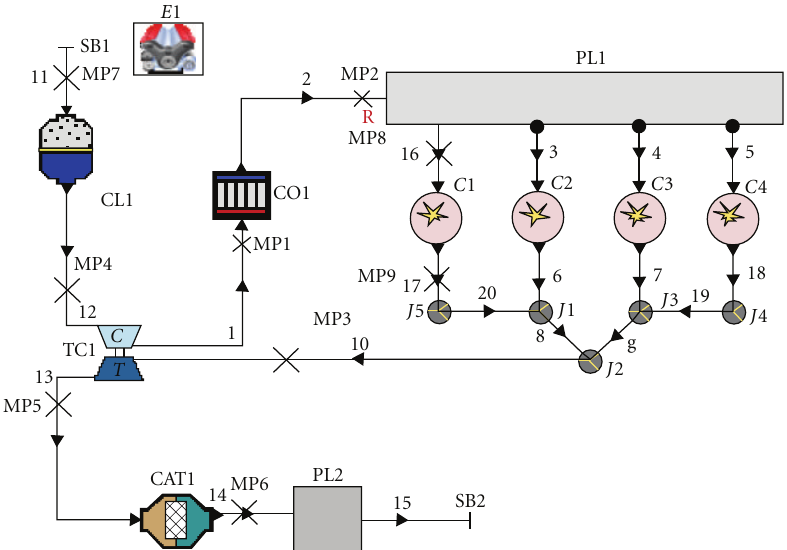
Figure 2: Simulation model of engine